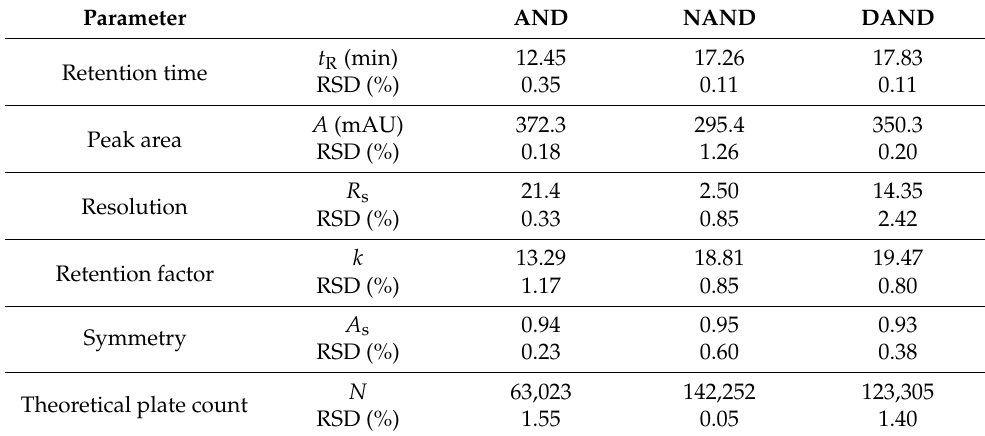
Table 2. System suitability ( n =